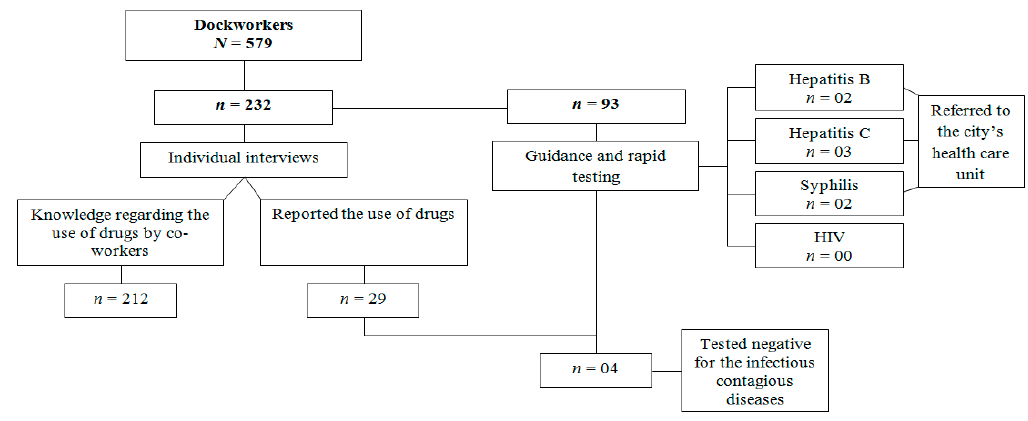
Figure 1. Scheme of the results.